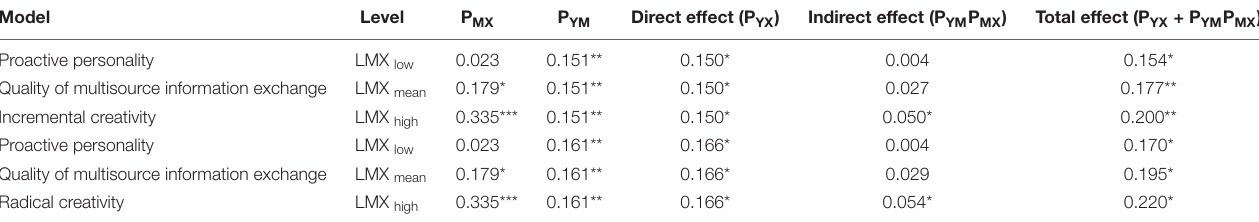
TABLE 5 | Effects at different